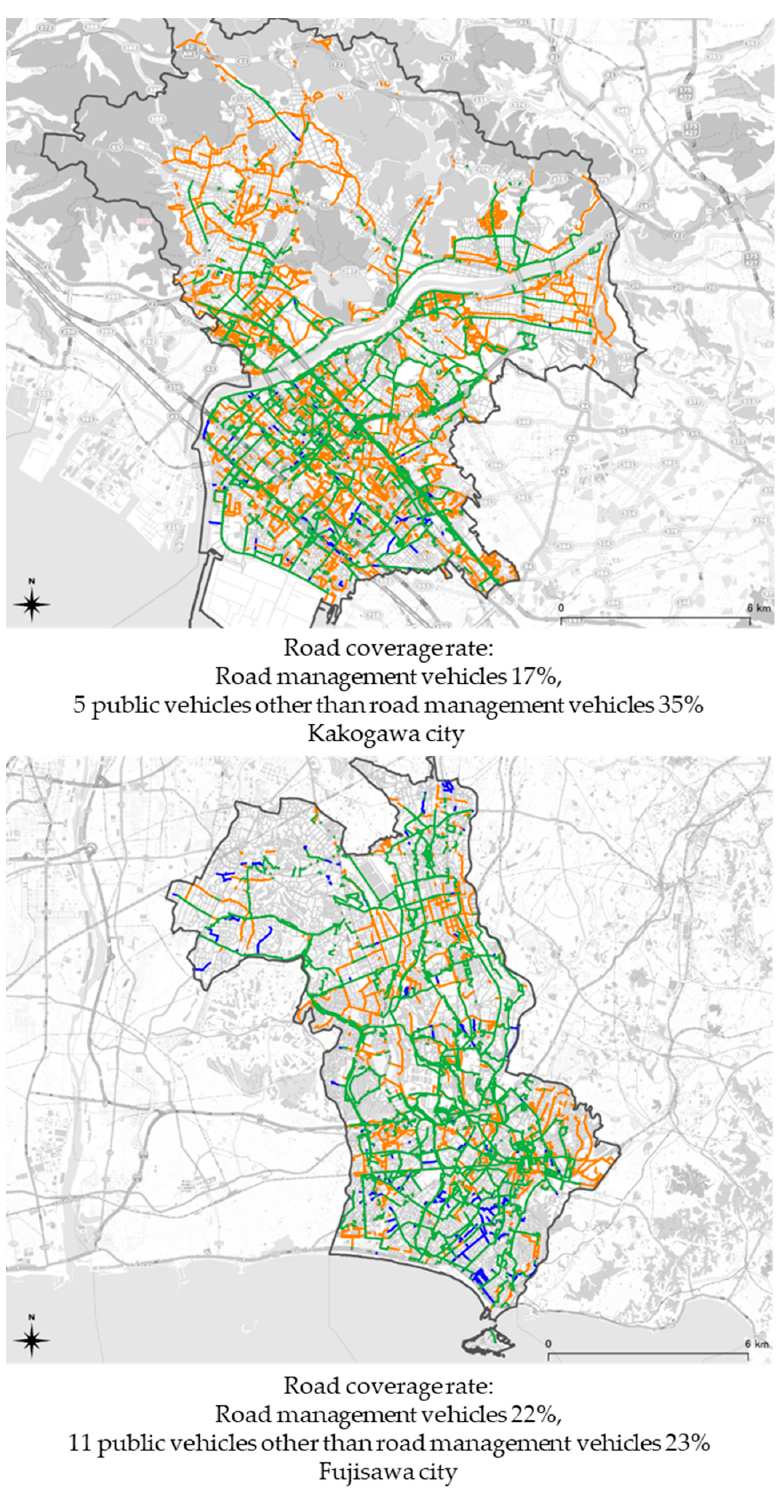
Figure 6. Road segments covered by road management vehicles and public vehicles with top X road coverage (selected public vehicles): Blue: Road segments covered by only road management vehicles, Green: Road management vehicles and selected public vehicles, Orange: Selected public vehicles. In Kakogawa city, only five public vehicles can cover the road inspection area. Although the number of road management vehicles in Kakogawa city is seven, this new discovery shows that